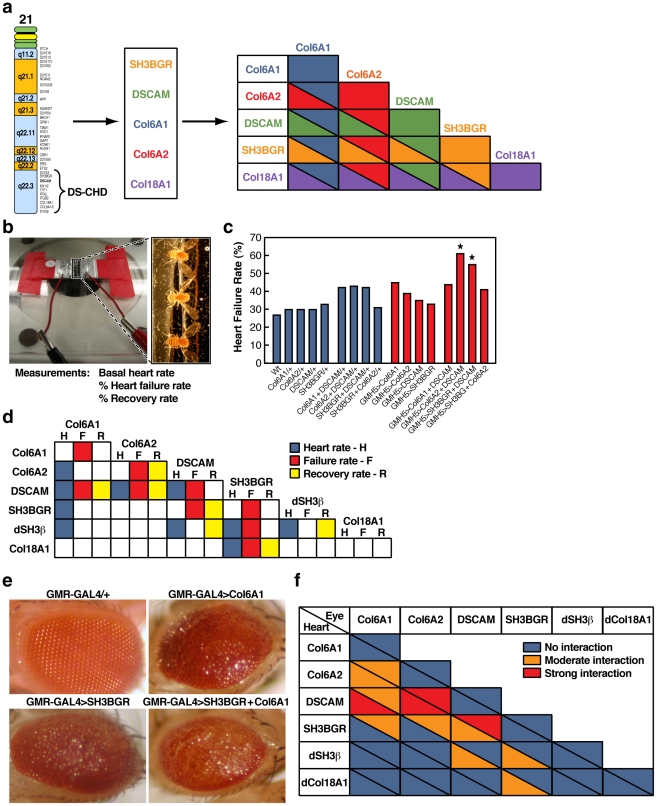
Survey of heart defects caused by over-expression of CHD candidate genes in the fly.a) Scheme depicting how candidate CHD genes from the distal region of chromosome 21 were screened by expressing them in the fly heart individually and in all possible pair-wise combinations. b) Electrical pacing heart performance stress chamber (left). Enlarged view of flies in pacing chamber (right). c) Example of increased heart failure rate in flies mis-expressing particular combinations of CHD candidate genes in the heart. The heart failure phenotype is presented as the percentage of flies whose heart fibrillated or stopped immediately following the pacing regimen (N = 200). (*Chi square p<0.05 for DSCAM+ COL6A2 and DSCAM+ SH3BGR). d) Interaction grid summarizing interactions between CHD candidate genes in the fly heart resulting in particular cardiac phenotypes. H  =  Heart rate, F  =  failure rate (% of flies that exhibited heart asystole or fibrillation immediately following the electrical pacing regime) and R  =  recovery rate (% of flies that exhibited recovered heart rate 2 minutes after the end of electrical pacing). Colored backgrounds indicate significant difference in heart function relative to non-expressing UAS controls (Chi square, p<0.05). Blue  =  heart rate; Red  =  stress-induced failure rate; Yellow  =  recovery rate following heart failure. e) Example of a genetic interaction between the CHD candidate genes SH3BGR and COL6A1 in the fly eye using the GMR-GAL4 driver. f) Summary of all genetic interactions between CHD candidate genes in the fly heart (lower triangles in each interaction box) and eye (upper triangles in each interaction box). Blue  =  no detectable interaction, orange  =  moderate interaction and red  =  strong interaction. The combination exhibiting the strongest interactions in both the heart and eye was DSCAM plus COL6A2.